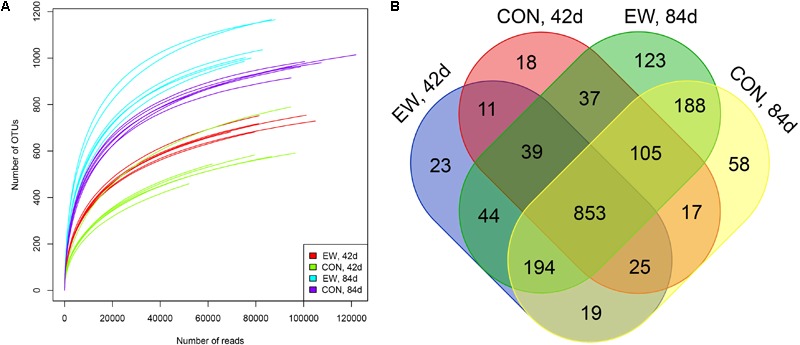
Number of operational taxonomic units (OTUs) in each group. (A) Rarefaction curves of OTUs; (B) Venn diagram of shared OTUs. EW, 42d: lambs were weaned at day 28 and sampled at day 42; EW, 84d: lambs were weaned at day 28 and sampled at day 84; CON, 42d: lambs were weaned at day 56 and sampled at day 42; CON, 84d: lambs were weaned at day 56 and sampled at day 84.